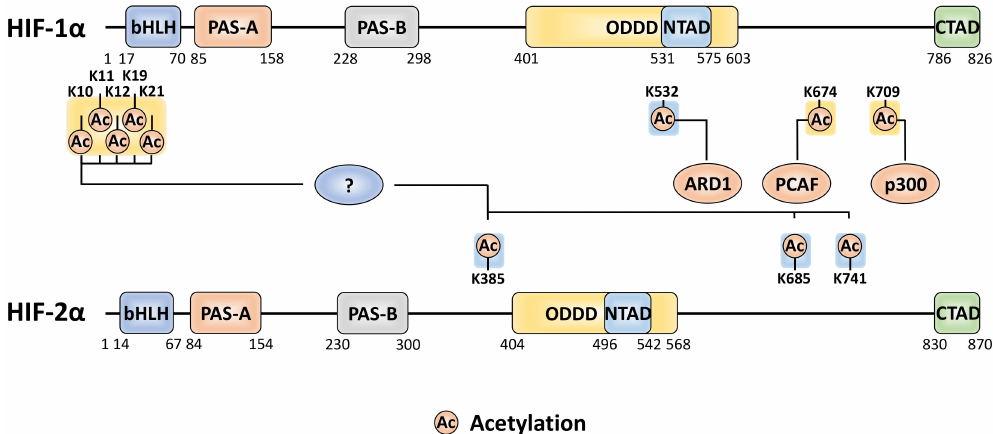
Figure 4. The amino acid sites of HIF- α subjected to acetylation and the acetyltransferase enzymes attributed to the relevant sites. A ‘?’ represents an unknown regulator, not currently described in the literature. PTMs with yellow and blue backgrounds indicate activatory and inhibitory effects,